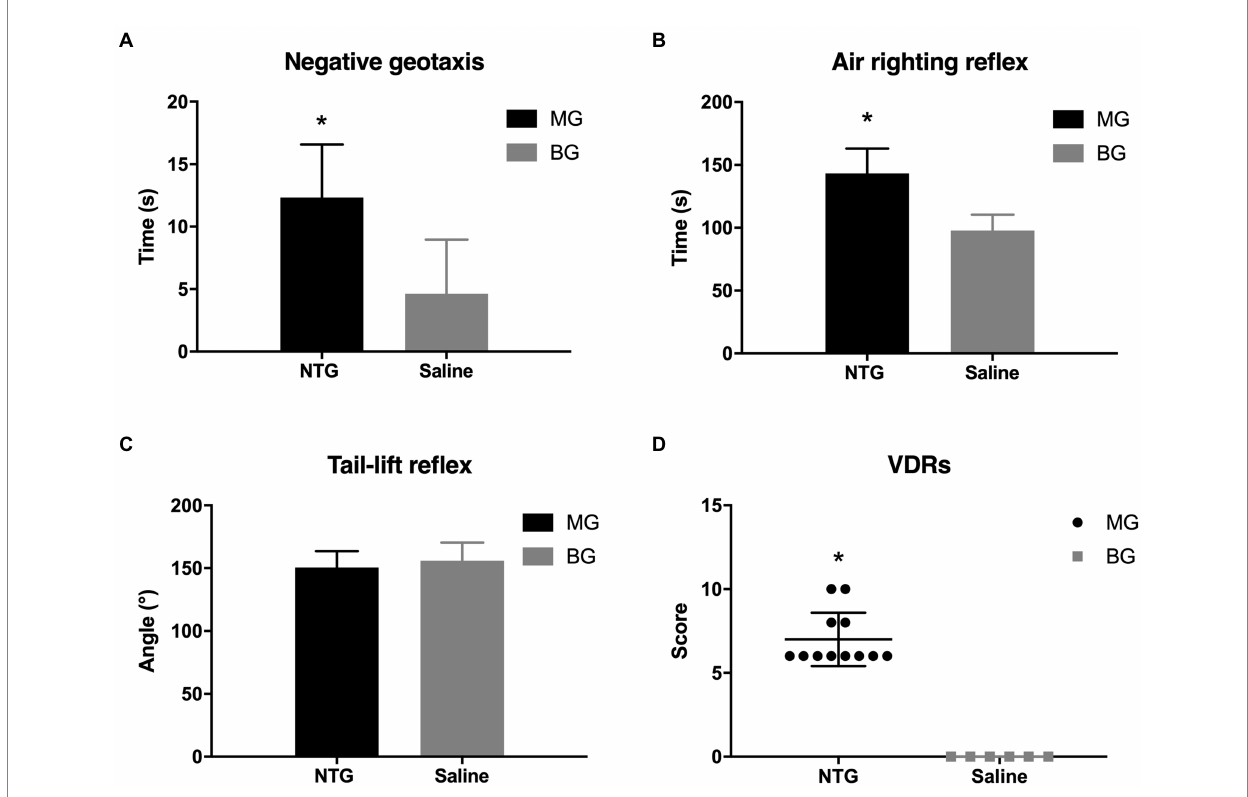
FIGURE 3 Recurrent NTG injection-induced vestibular dysfunction. Compared with rats in BG, rats in MG spent a significantly longer time in the negative. Geotaxis test (A) and the air-righting reflex test (B) , as well as scored higher in the VDRs (D) . In the tail-lift reflex test (C) , however, no significant difference was observed between MG and BG in the angle formed by the tip of the nose, in the back of the neck, and the base of the tail. * p < 0.05.